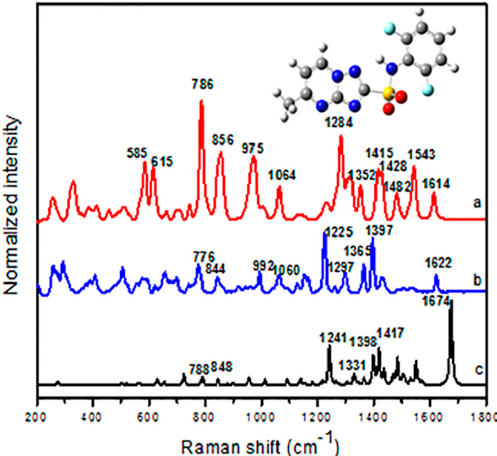
Figure 3. Theoretical and experimental spectra of the flumetsulam molecule (a: Experimental surface-enhanced Raman scattering (SERS) spectrum, b: Experimental normal Raman spectrum of flumetsulam powder, c: Simulated Raman Spectra of the free flumetsulam molecule).